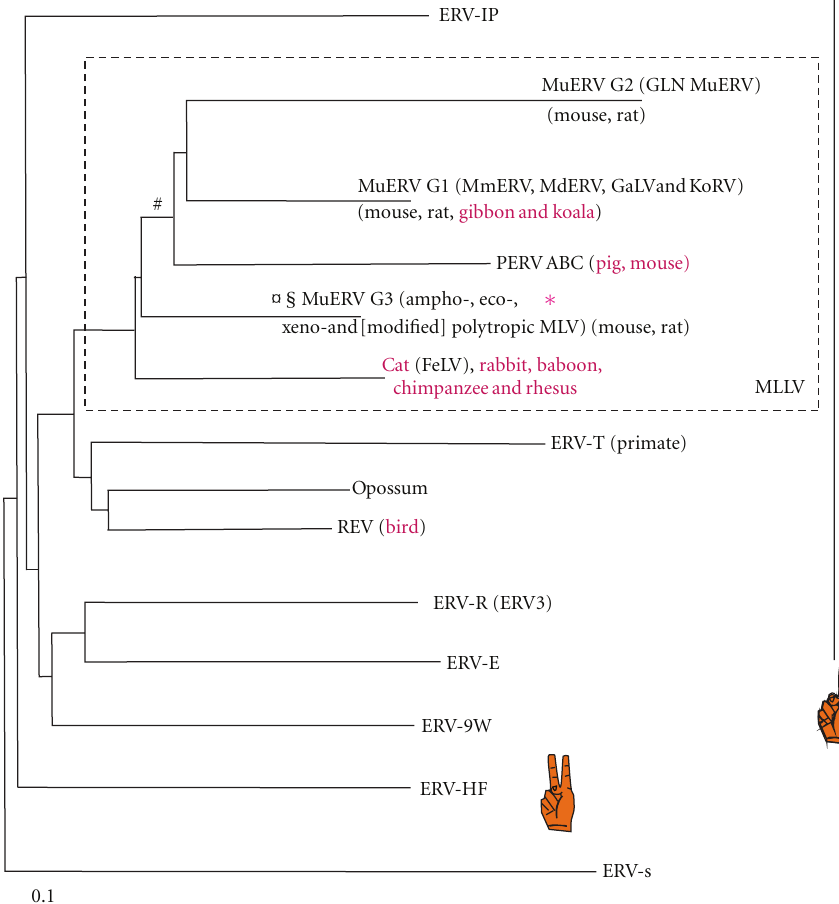
thereby being transmitted to the next generation,